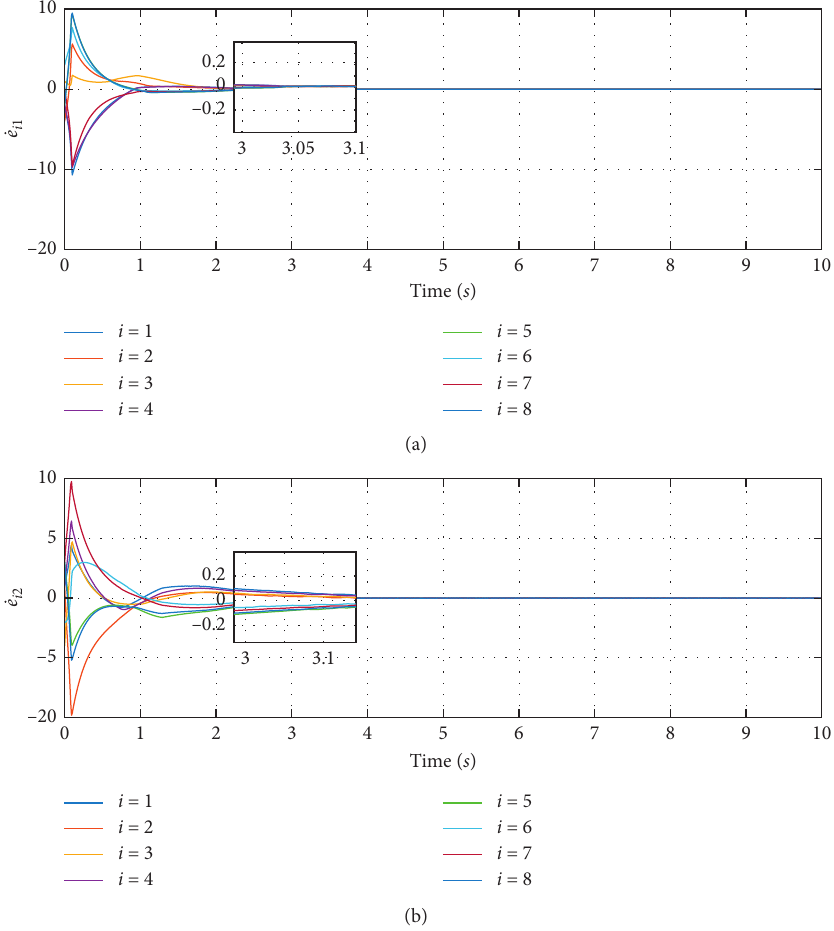
Figure 9: Pictures (a) and (b) reveal the evolution of the velocity tracking errors for links 1 and 2.